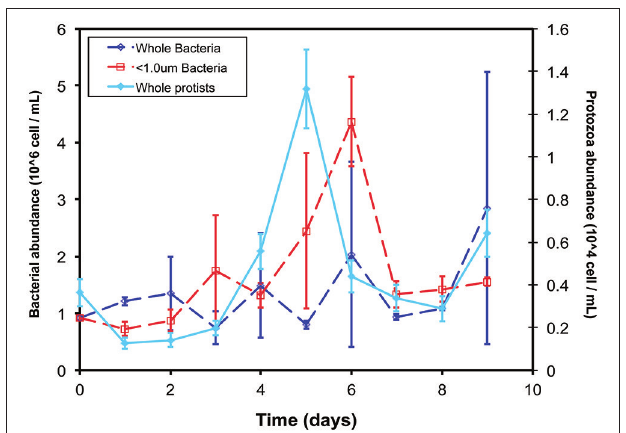
FIGURE 1 | Cell abundances over time of experiment. Bacteria (open symbols, dotted lines, left y-axis) were enumerated with flow cytometry and protozoa (closed symbols, solid line, right y-axis) were enumerated with epifluorescence microscopy in the < 1.0- µ m (red) and whole-water (blue) incubations. No protozoa were detected by microscopy in the < 1.0- µ m incubations. Data presented are the mean and standard deviation of replicate counts in two experimental replicate bottles ( n = 6).